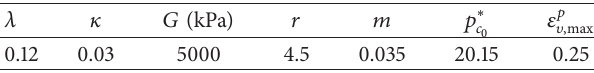
Table 2: Mechanical parameters of Pearl